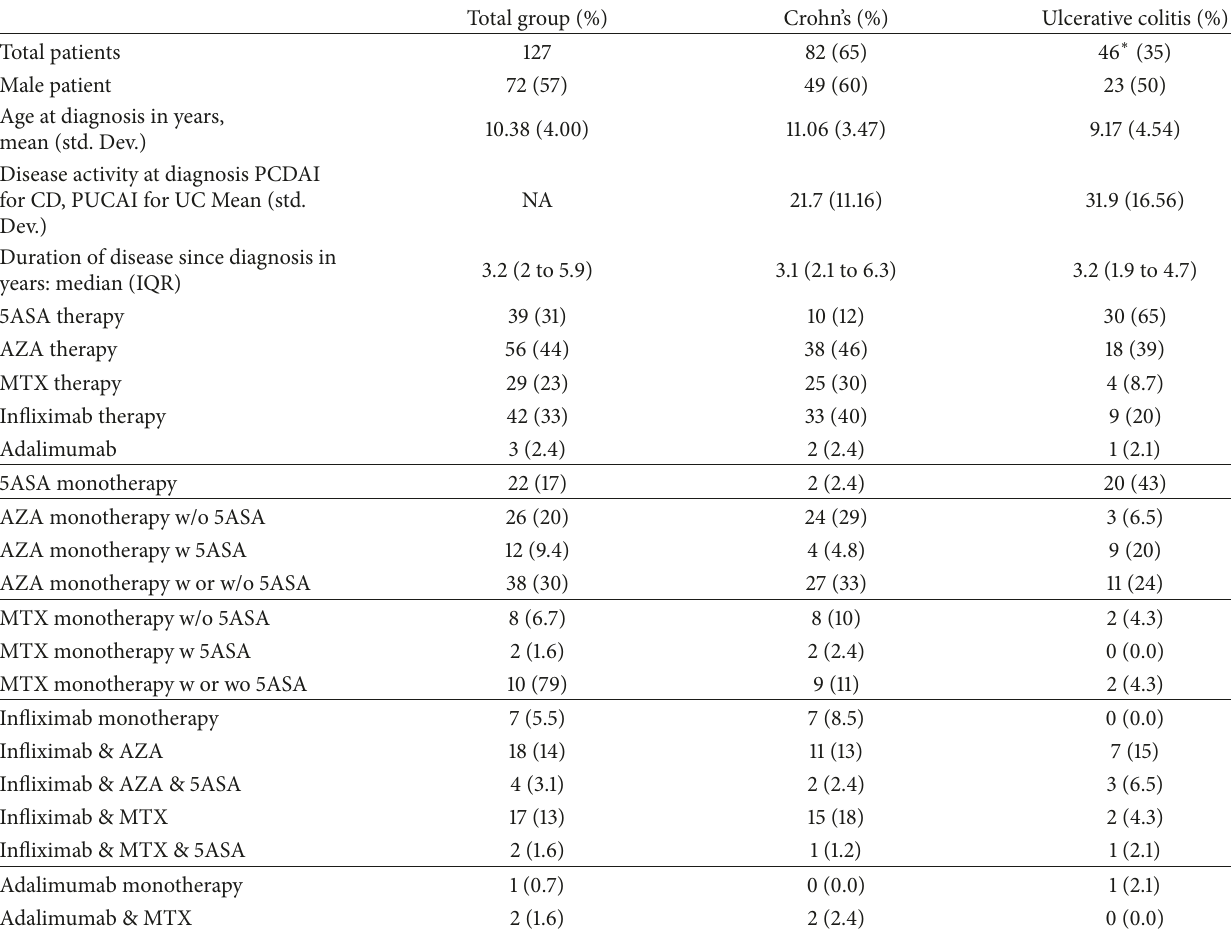
Table 1: Patient demographics and medication treatment.